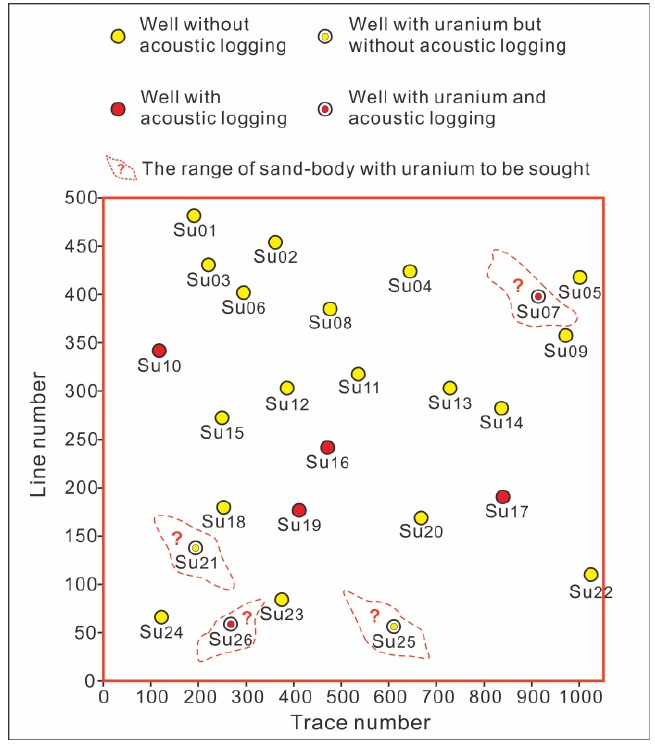
Figure 1. Background and problems.